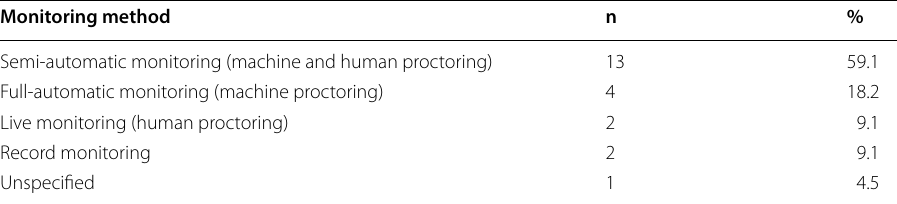
Table 6 Monitoring methods used in online assessment systems Monitoring method n % Semi-automatic monitoring (machine and human